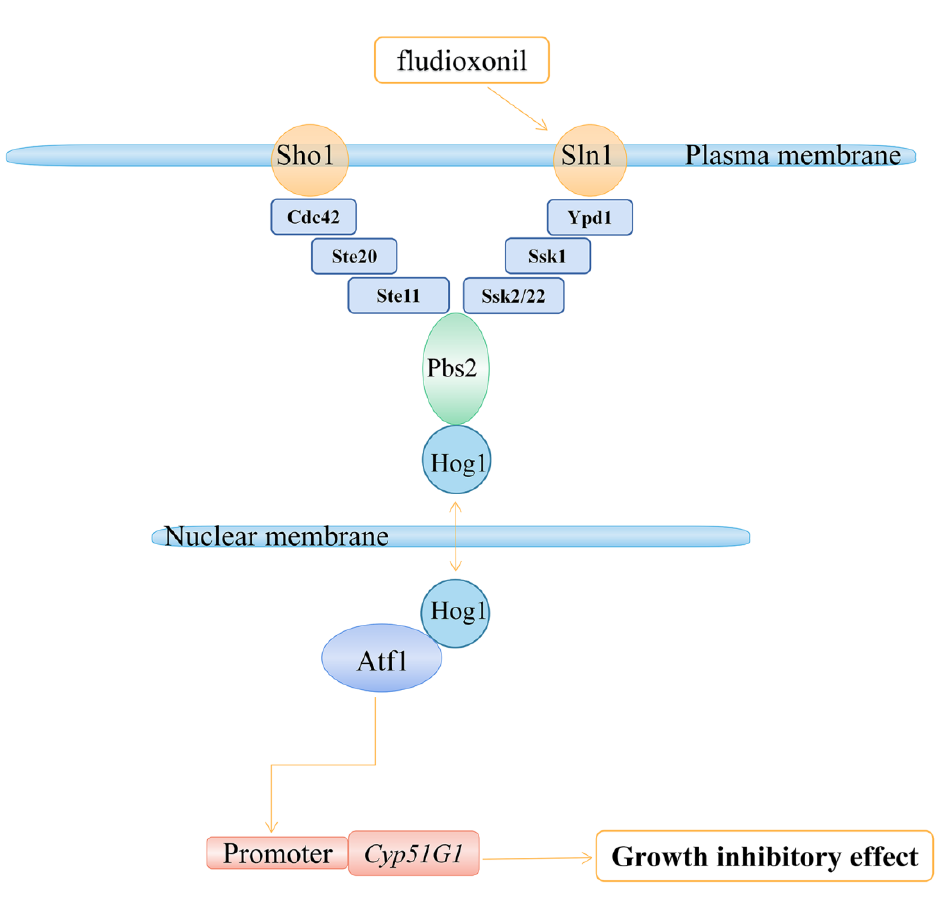
sites in the genome. Figure S6: GO enrichment analyses of genes probably affected by CsAtf1. Figure S7: KEGG enrichment analyses of genes probably affected by CsAtf1. Figure S8: Sequence logos showing the three most enriched motifs in ChIP-Seq. The size of the base represented the possibility of the base appearing. Table S1: List of primers used in the study. Table S2: Cytochrome oxidase related genes that probably directly regulated by CsAtf1.